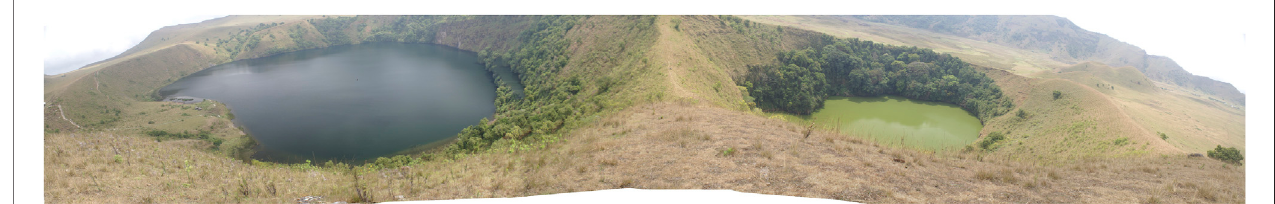
FIGURE 5 | The Manengouba Female (left – black) and Manengouba Male (right – green) crater lakes of Mt Manengouba (Cameroon; picture by P. Hernández).